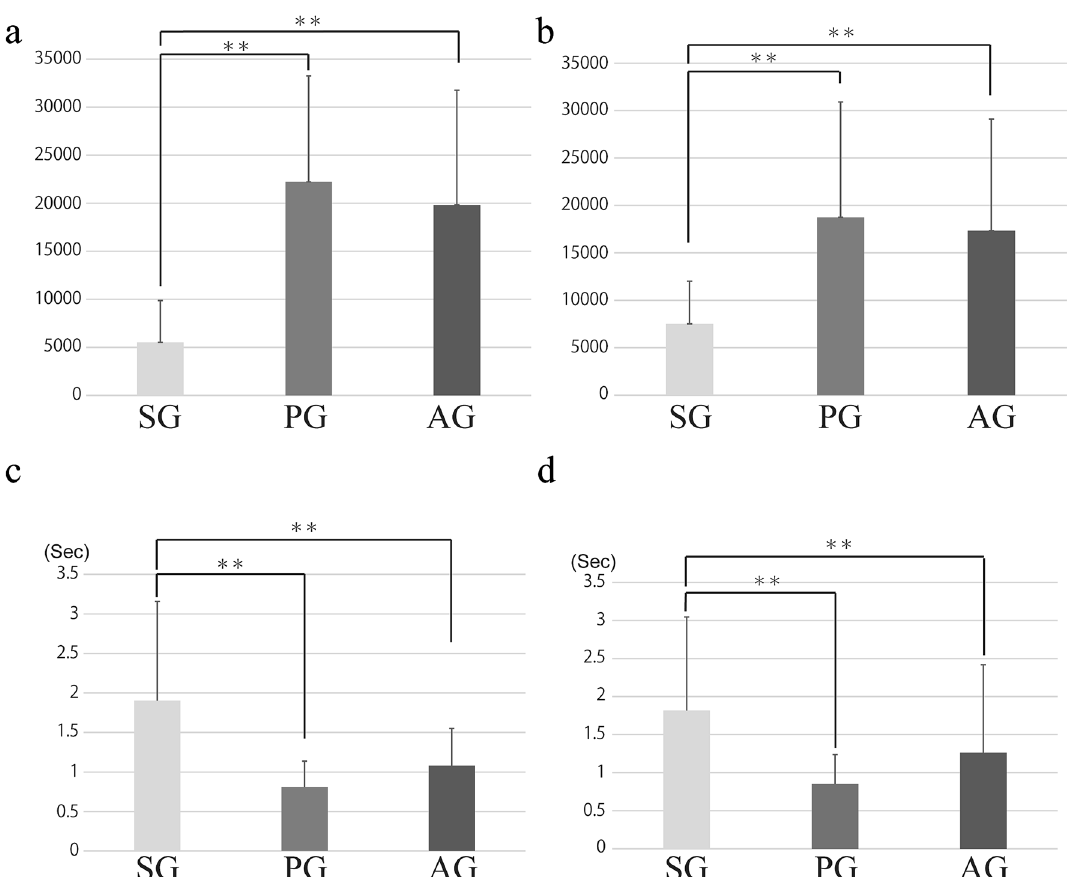
Figure 4. ( a ): The length of SG for ESBS was significantly longer than those of PG and SG. ( b ): The length of SG for ESAS was significantly longer than those of PG and SG. ( c ): The amplitude value of SG for ESBS was significantly lower than those of PG and SG. ( d ): The amplitude value of SG for ESAS was significantly lower than those of PG and